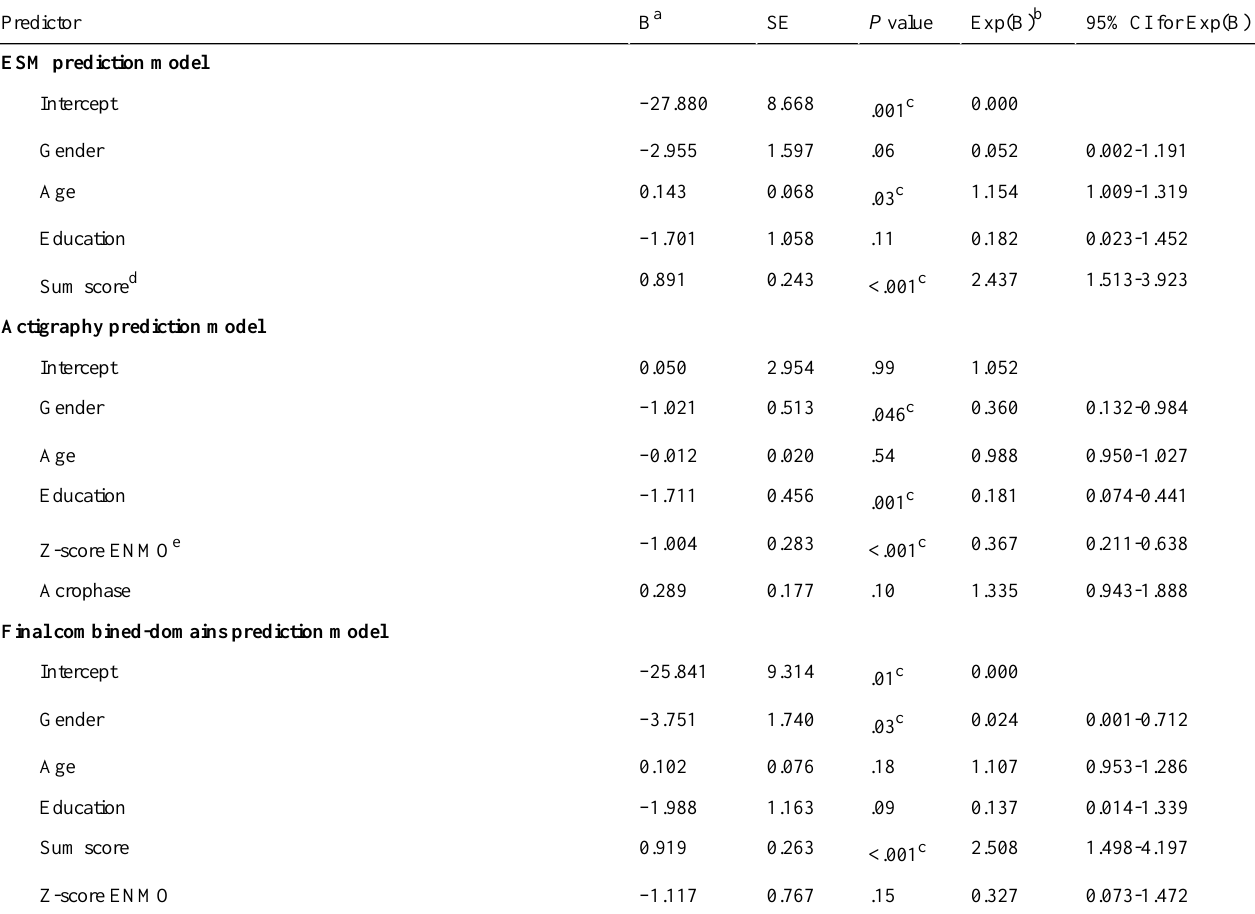
Table 2. Predictors of depression included in the experience sampling method (ESM) prediction model, the actigraphy prediction model, and the final combined-domains